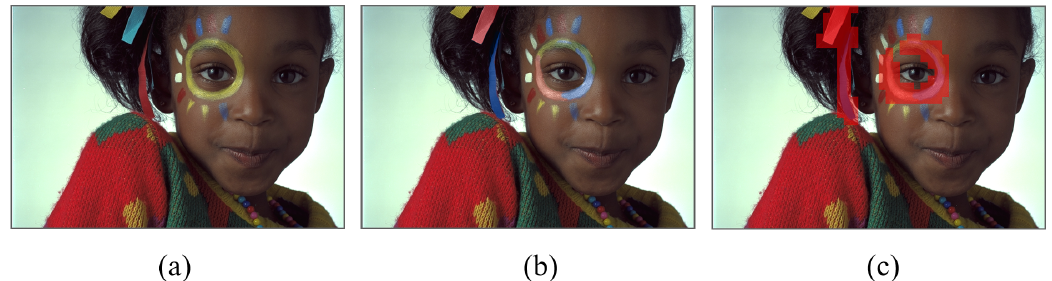
Figure 22. The simulation result of testing on an RGB image. ( a ) Test image. ( b ) Tampered image. ( c ) Tampered area detection